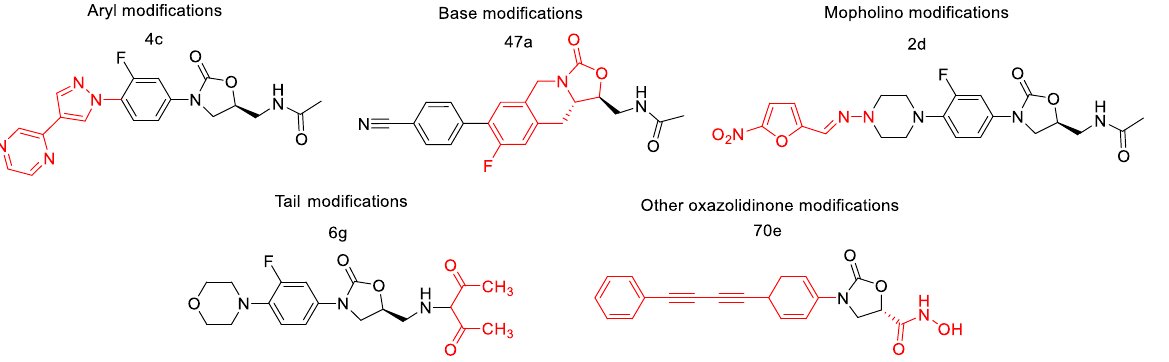
Figure 5. The following structures show the modification to the oxazolidinone derivatives based on the linezolid structure in red. They are split into the following categories: morpholino modifications ( 2d ), aryl modifications ( 4c ), base modifications ( 47a ), tail modifications ( 6g ), and other oxazolidinone modifications ( 70e ). Note that some structures have multiple areas of modification. This image is to detail an example of what these modifications may be.